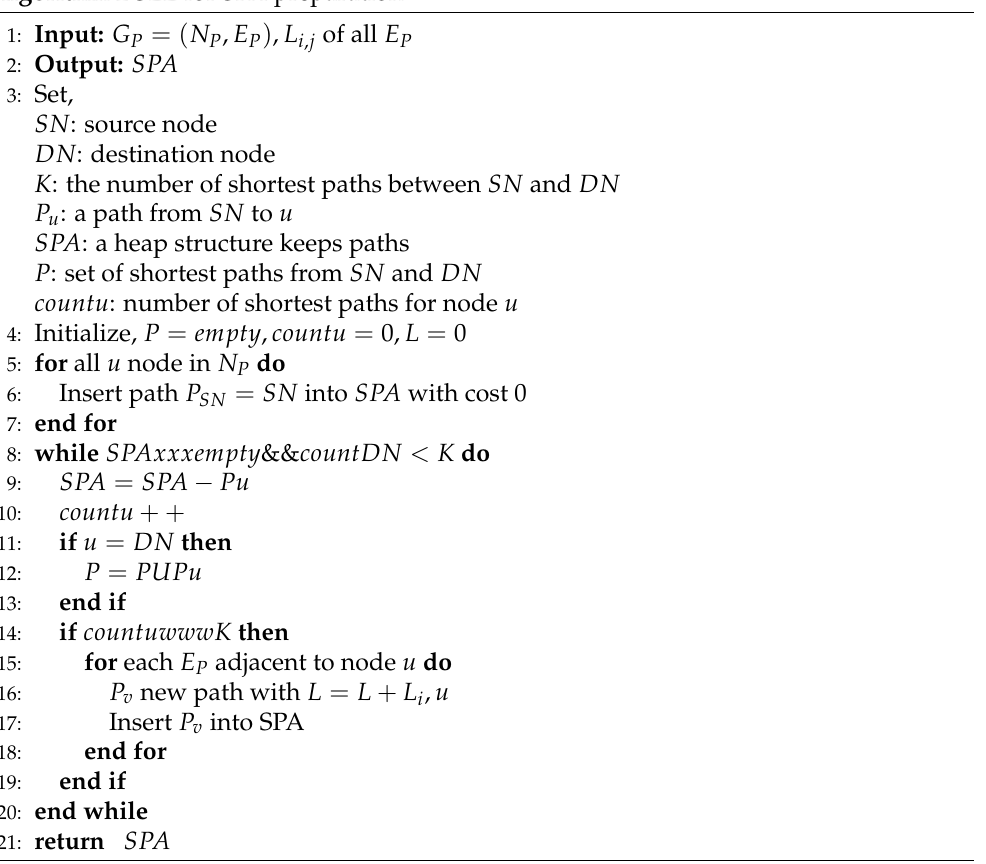
Algorithm 2 SLE for SPA